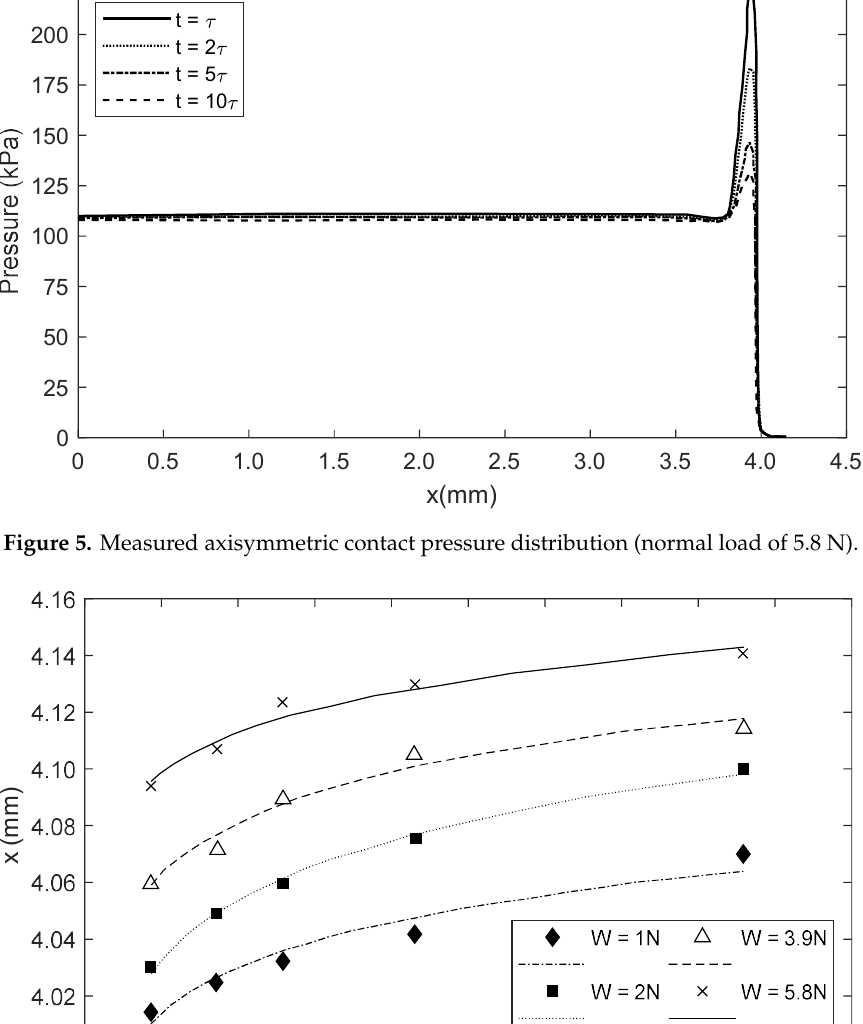
Figure 4. Measured axisymmetric contact pressure distribution (normal load of 3.9 N).